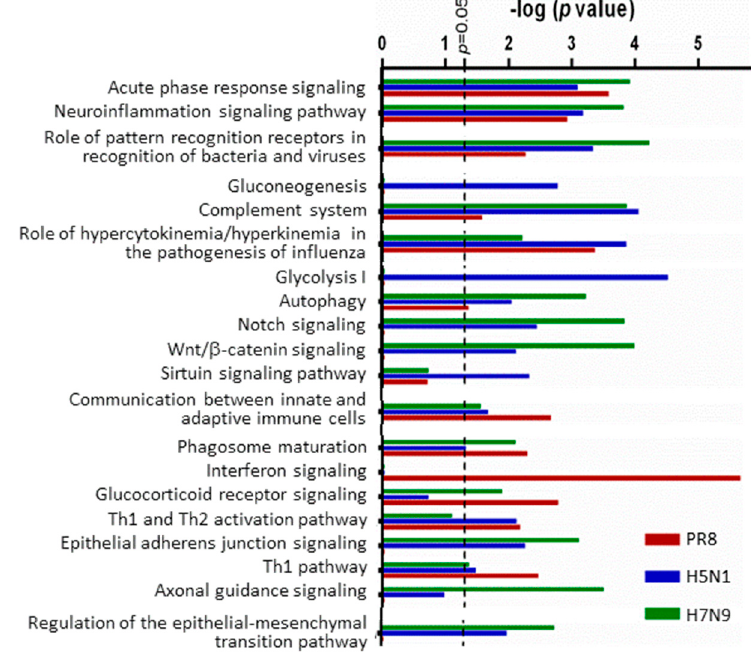
Figure 5. Comparison of cellular canonical signaling pathways affected by various IAV strains. Only the top 20 IPA ® -identified canonical pathways and their indicated p -values are shown. RV733 and pdm09 did not activate any of these pathways.